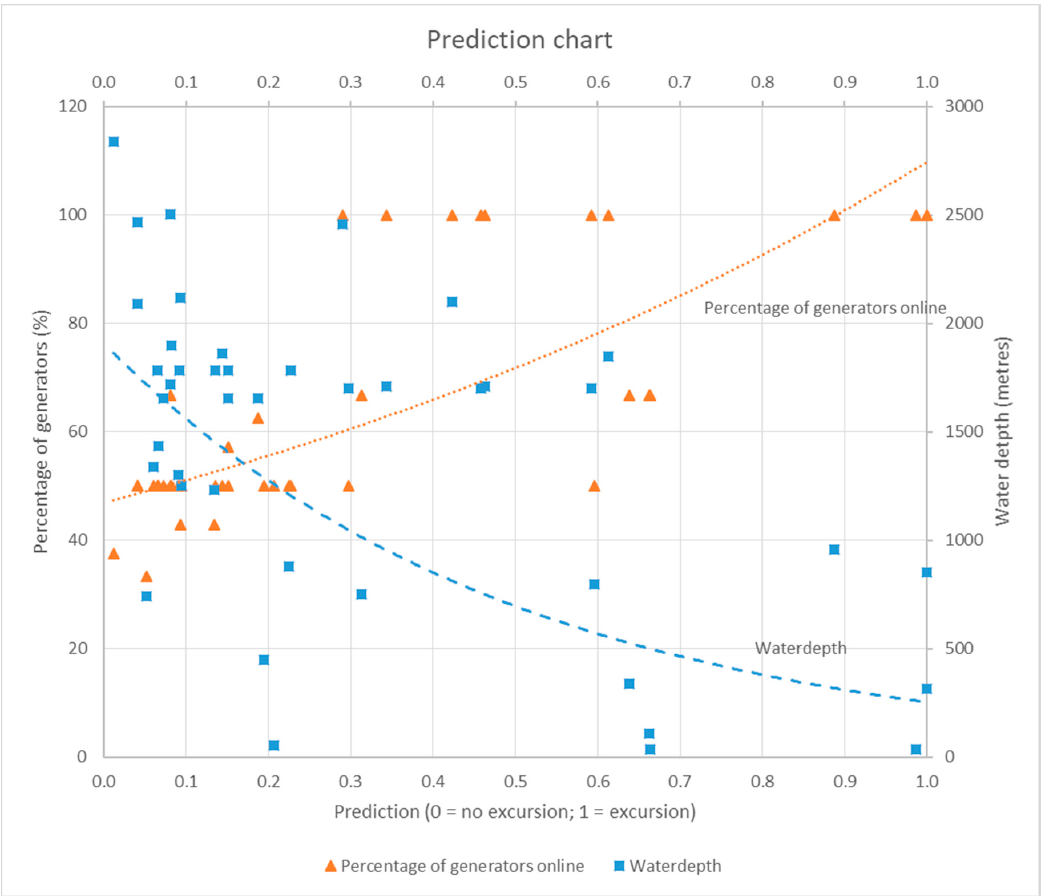
Figure 5. Prediction chart showing the trends for water depth and percentage of generators according to the prediction model.